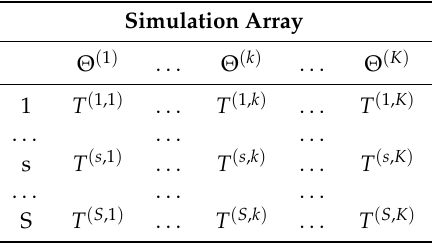
Table 1. We provide an immediate visualization of what was described in the step 2. T stands for the trapezoid obtained adding to the original triangle the new diagonal containing simulated payments of first calendar year after the evaluation date. The upper parenthesis locates the simulated diagonals in terms of parameter set k and number of simulations s